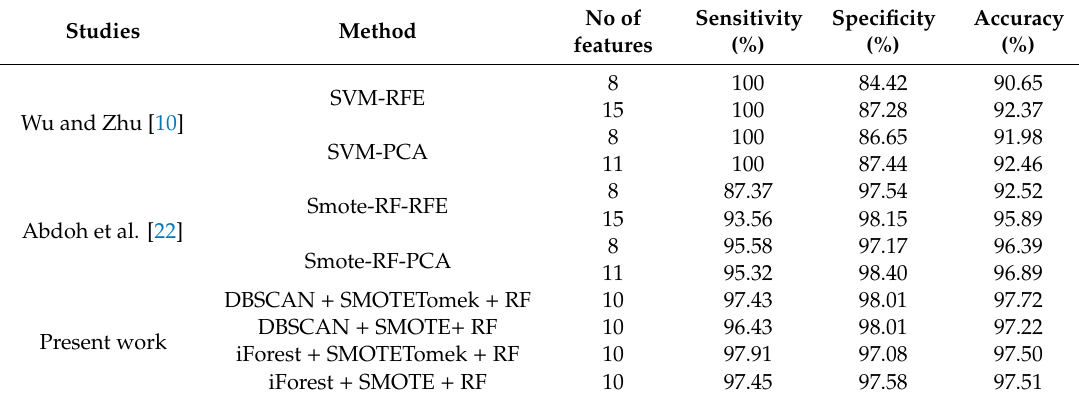
Table 25. Comparison of CYTOLOGY TEST results of CCPM with past